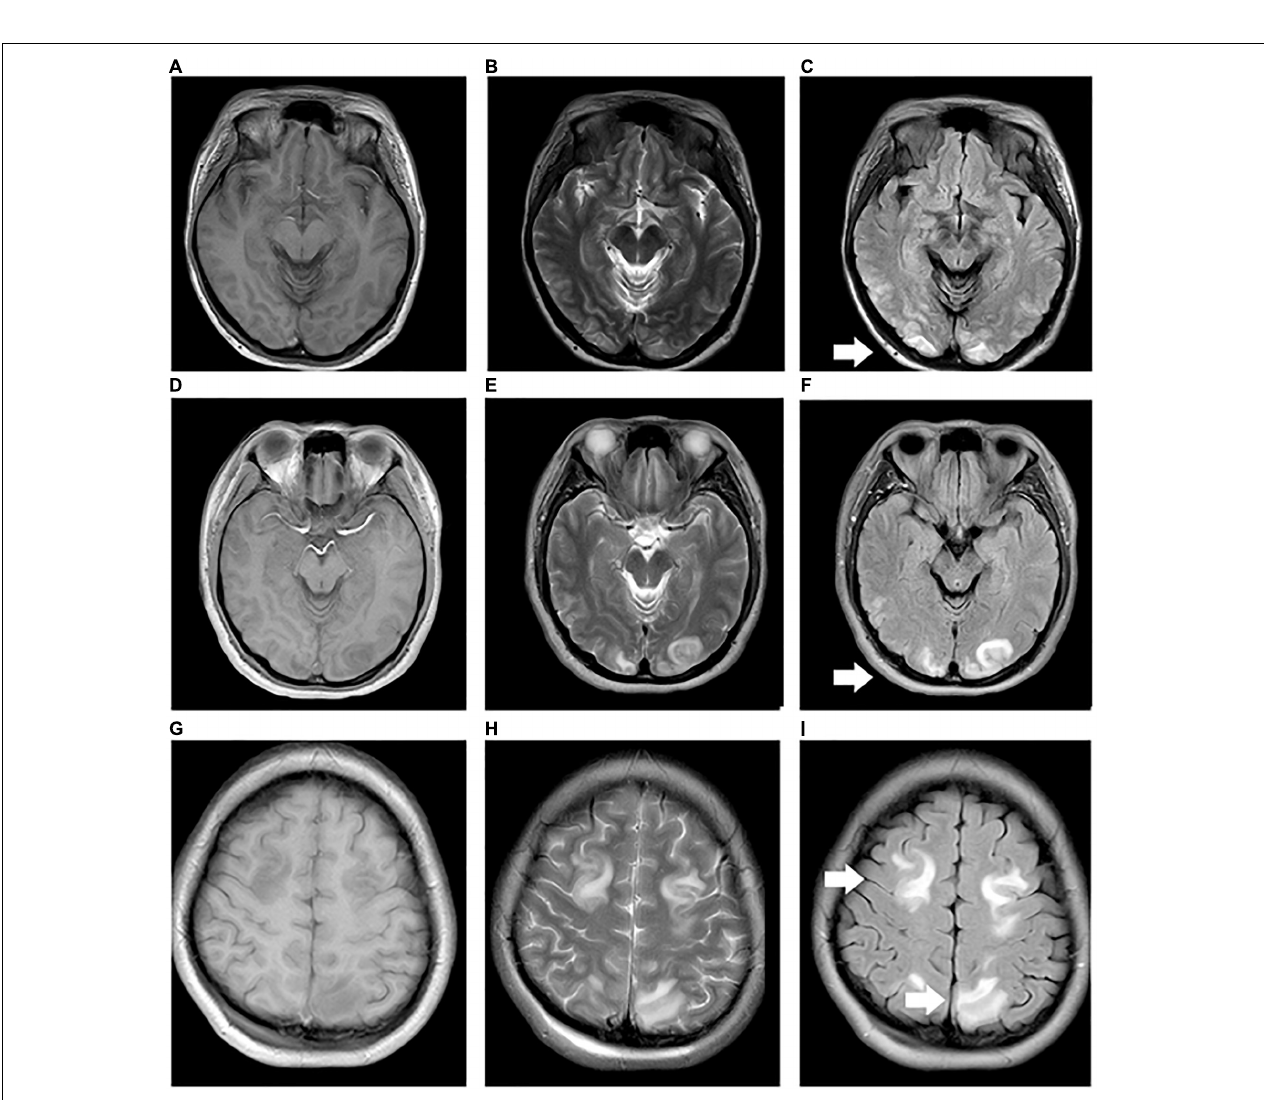
FIGURE 4 | Maternal preversible encephalopathy syndrome. (A–I) Maps showing 33, 28, and 24 year-old pregnant women (BH: 200/130, 160/110, and 180/110 mmHg) with decreased signal intensity on T 1 WI, and increased signal intensity on T 2 WI and FLAIR in bilateral occipital regions, bilateral occipital and right temporal regions, and bilateral parietal and frontal regions,